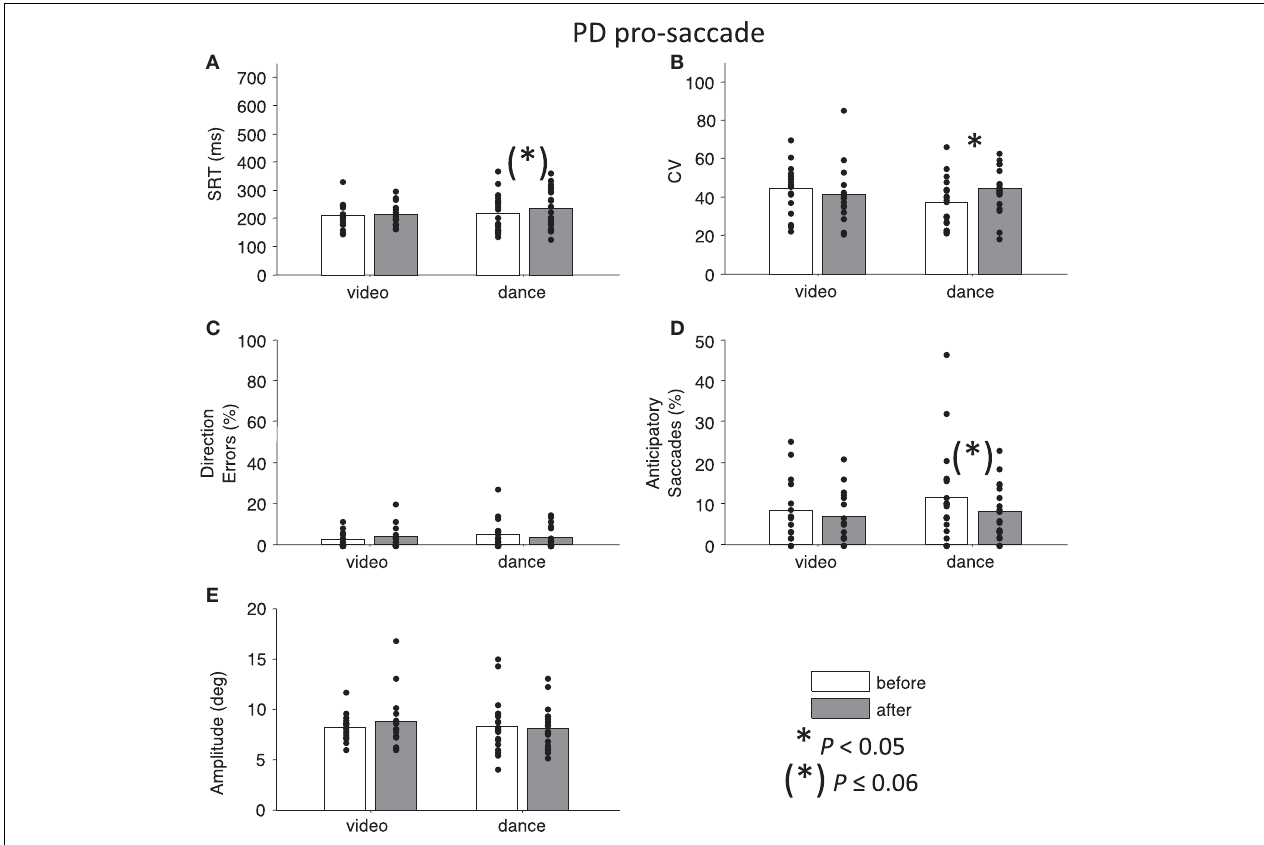
anticipatory saccades. (E) Saccade amplitude. Dots indicate each participant. Asterisks indicate significant differences between before and after measurements (paired t -tests, P <